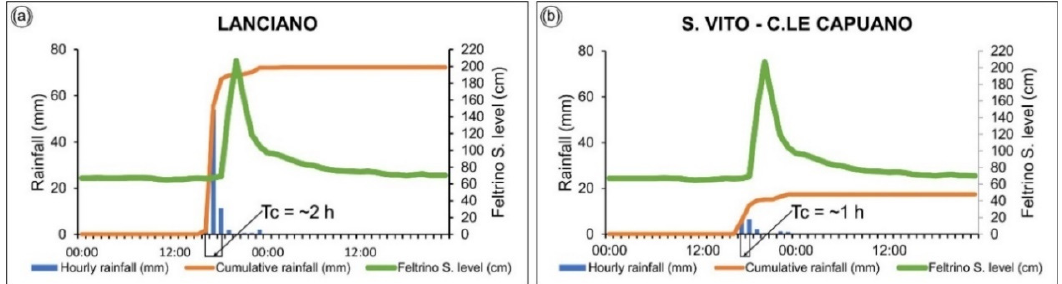
Figure 8. Hourly and cumulative rainfall, and the hydrographic level and time of concentration (Tc) of the Feltrino Stream (Feltrino–S. Vito gauge), during the event of June 2018; ( a ) Lanciano gauge; ( b ) S. Vito–C.le Capuano gauge (for the gauges’ locations, see Figure 4).